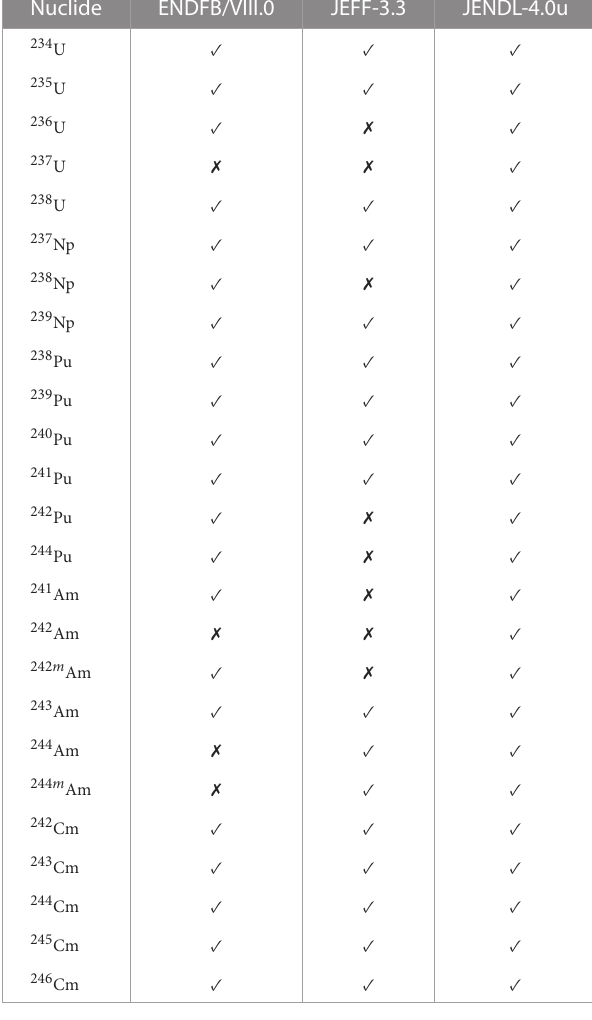
TABLE1 Actinideswhosecross-sectioncovariancematriceswereconsidered intheuncertaintypropagationstudy.